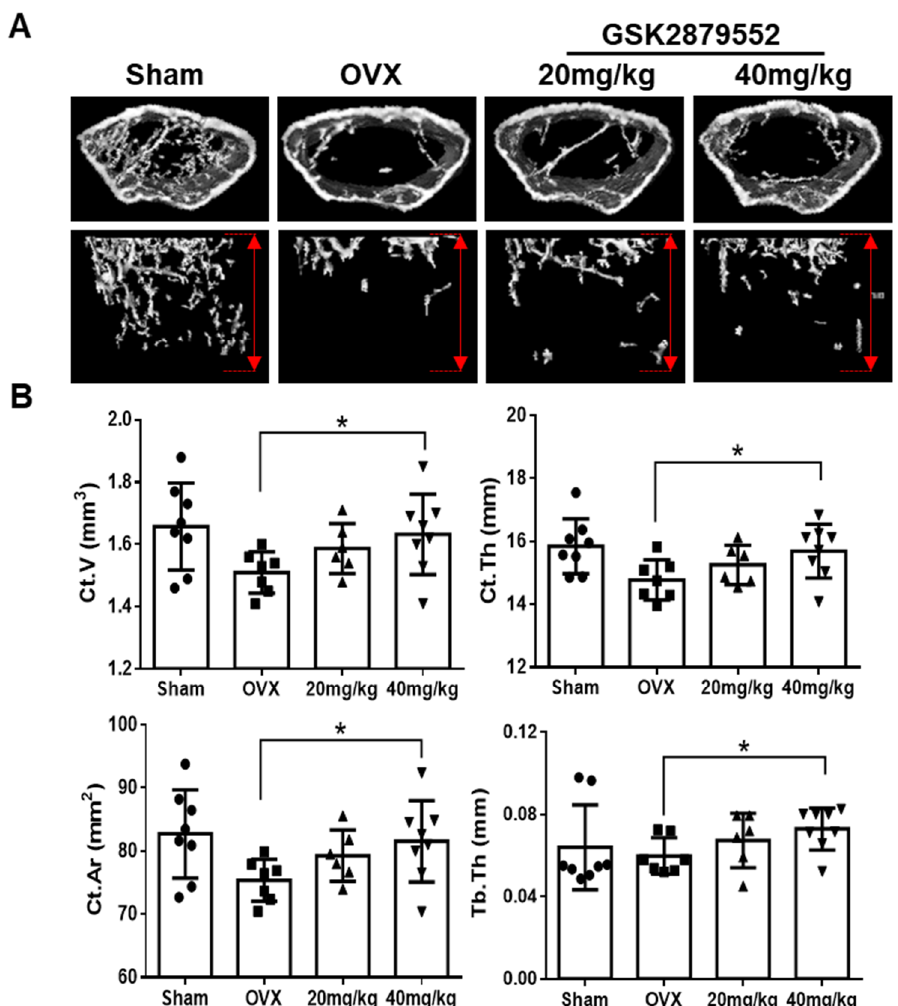
Figure 7. GSK2879552 suppressed OVX-induced osteoporosis in mice. ( A ) Fixed femurs of mice were analyzed by micro-computed tomography in the Sham, OVX, GSK-2879552 (20 mg/kg and 40 mg/kg) treatment groups. Three-dimensional reconstructed images of the cortical bone ( top ) and the trabecular bone ( bottom ) of mice femurs are shown. The length of the y -axis of the area of analysis was marked by a red double arrow, which indicates 2 mm below the epiphyseal plate of the bone in each group. ( B ) Ct.V, Ct.Th, Ct.Ar, and Tb.Th were measured for each sample. Values are